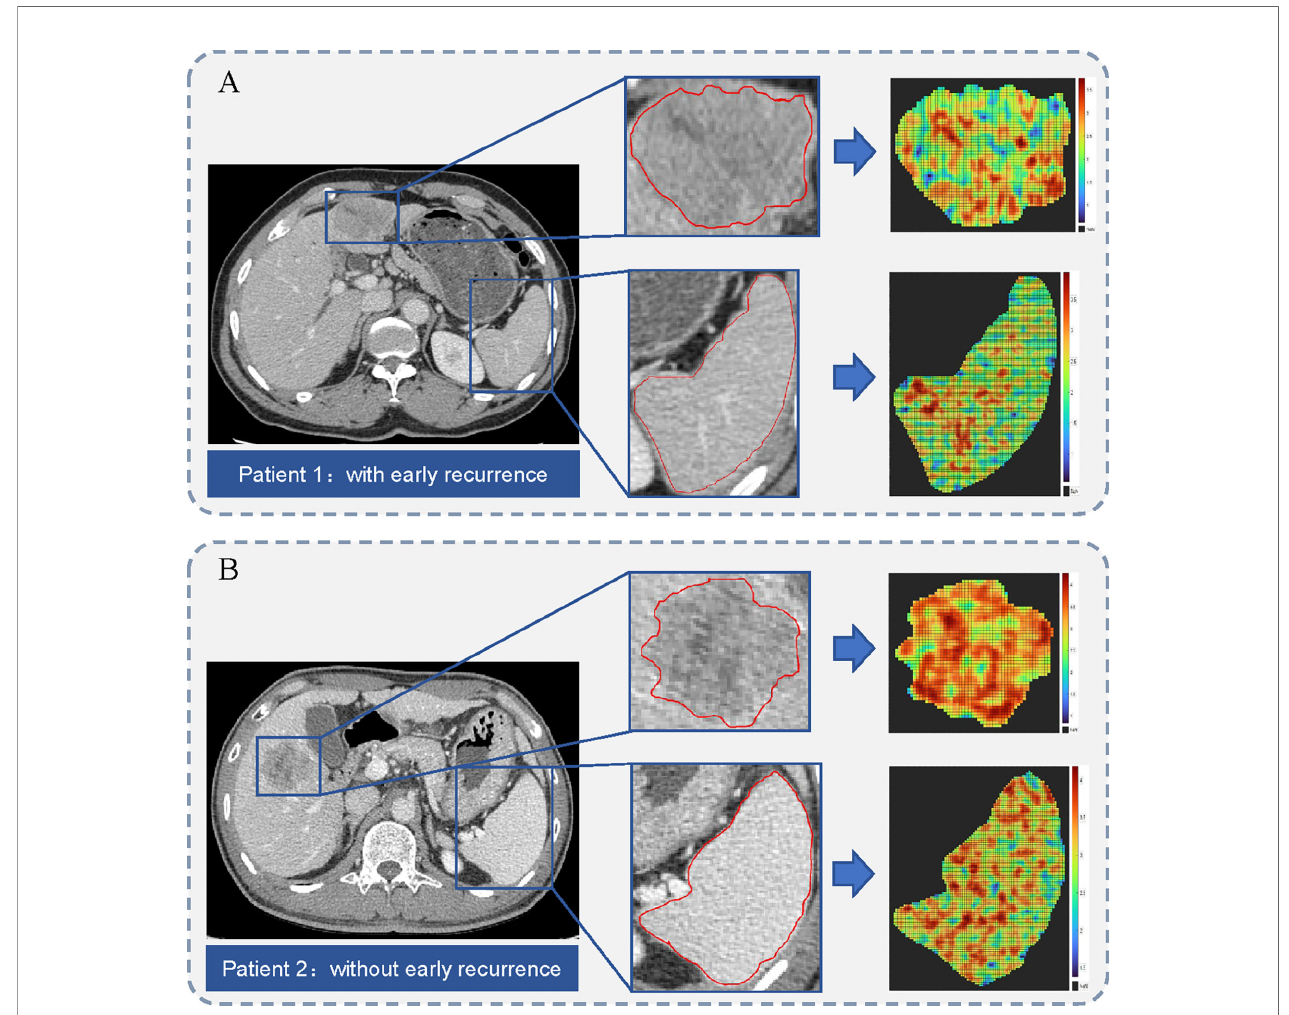
FIGURE 3 | Illustration of region of interest (ROI) segmentation for two representative cases. The middle column shows the tumor and spleen outlines on the original CT image. The right column shows the heat maps of radiomics score on tumor and spleen images. (A) A 68-year-old man with microvascular invasion (MVI) and a 49-mm liver mass. Hepatic metastasis occurred 12.4 months after surgery. (B) A 48-year-old man with MVI and a 40-mm liver mass. He remained recurrence-free during 74.3 months of follow-up period after